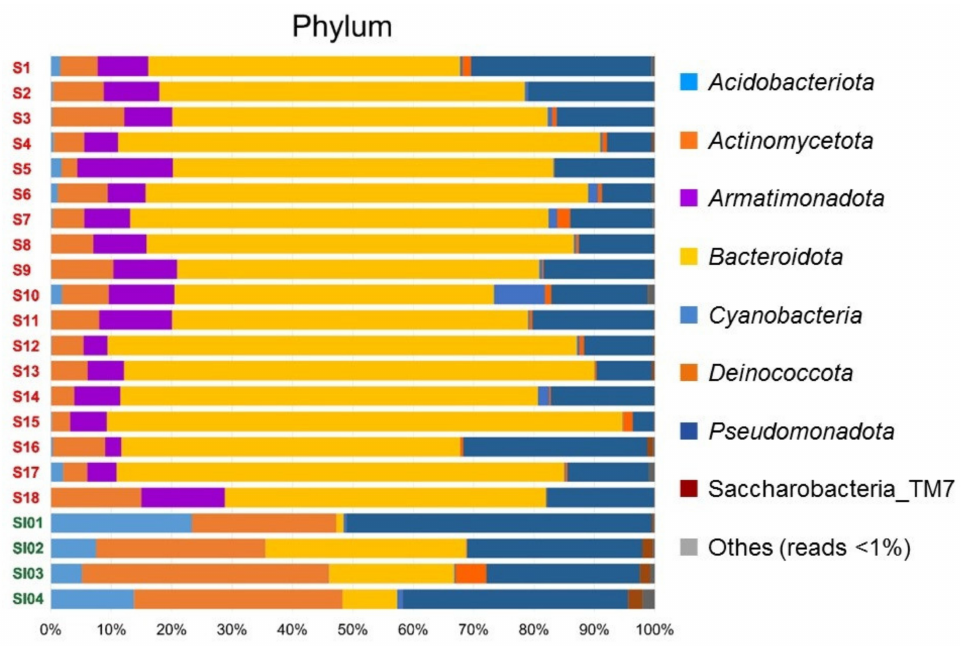
Figure 2. Bacterial phylum compositions of OTUs obtained from lichen samples from the Syowa Sta- tion region in continental Antarctica (S1 to S18) and Signy Island in maritime Antarctica (SI01 to SI04). Eight phyla were observed with read abundances of >1% of the total read number. Compositions of bacterial classes, orders, families, genera and species are shown in Figures